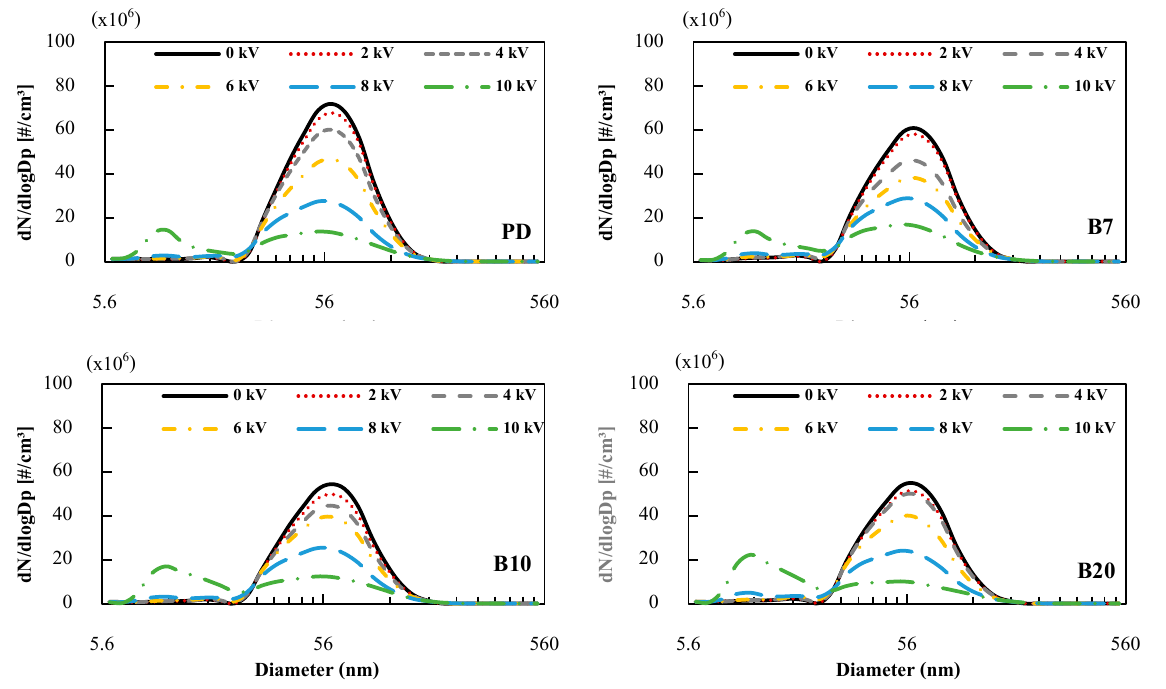
Figure 7. Effect of NTP on the particulate number distribution at an engine speed of 2000 rpm and IMEP 6 bar.